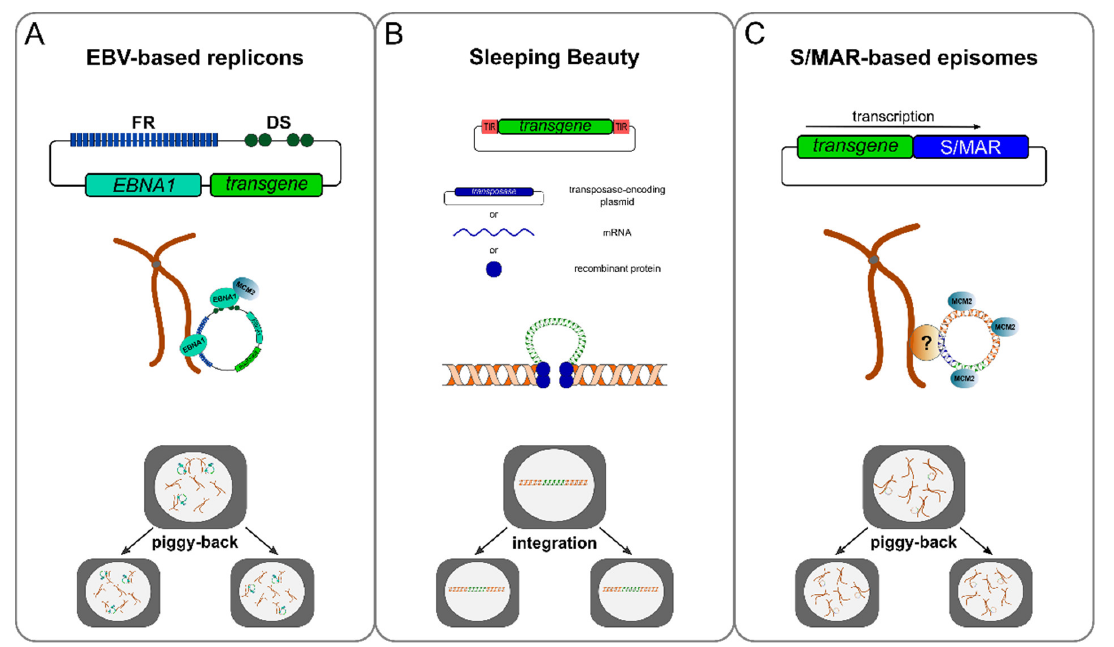
Figure 2. Mechanisms of DNA replication and nuclear retention of different nonviral vector systems. ( A ) EBV-based replicons replicate EBNA1 and MCM2-7 dependent. The binding of EBNA1 to